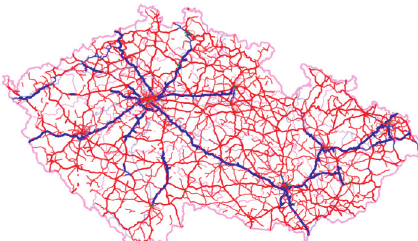
Figure 2: Visualization of TMC segments covering all main roads displayed on the map of the Czech Republic. Blue highlights motorways, red highlights major roads, and pink highlights 1 st –3 rd class roads. All road types in the Czech Republic and their equivalents according to OpenStreetMap can be found in Section